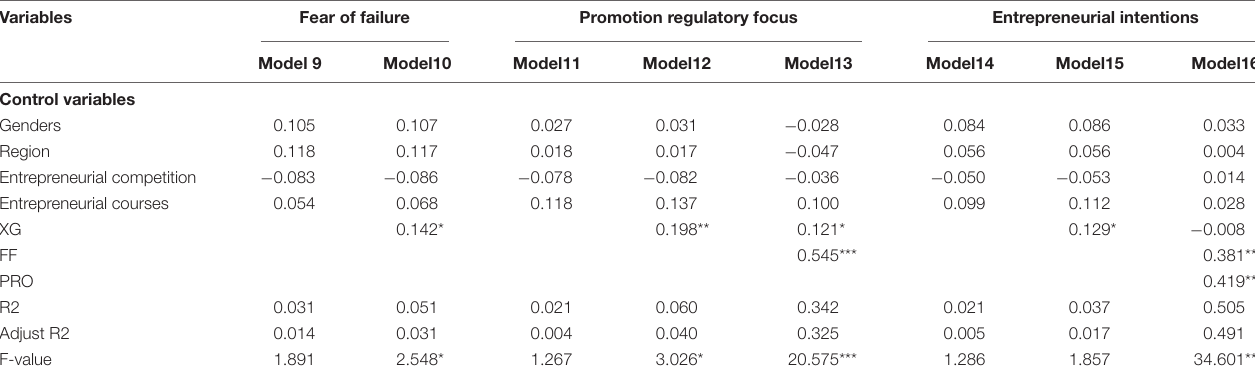
TABLE 5 | Regression analysis results (PRO